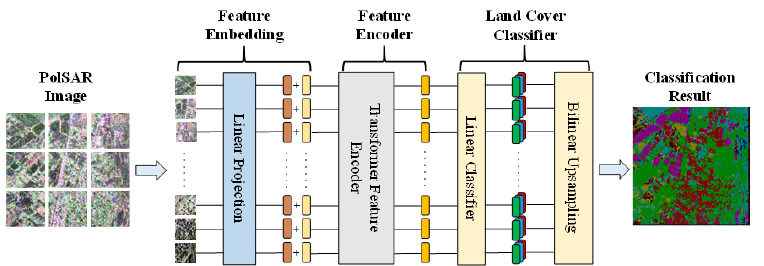
Figure 2. The scheme of the proposed PolSAR image land cover classification